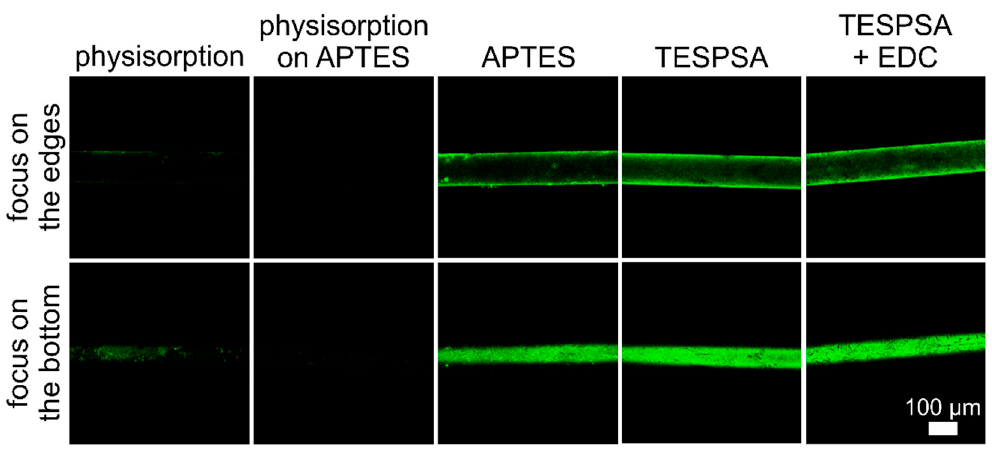
Figure 3. Analysis of different methods of protein immobilization on the optical fiber surface. GFP was used as a model protein.